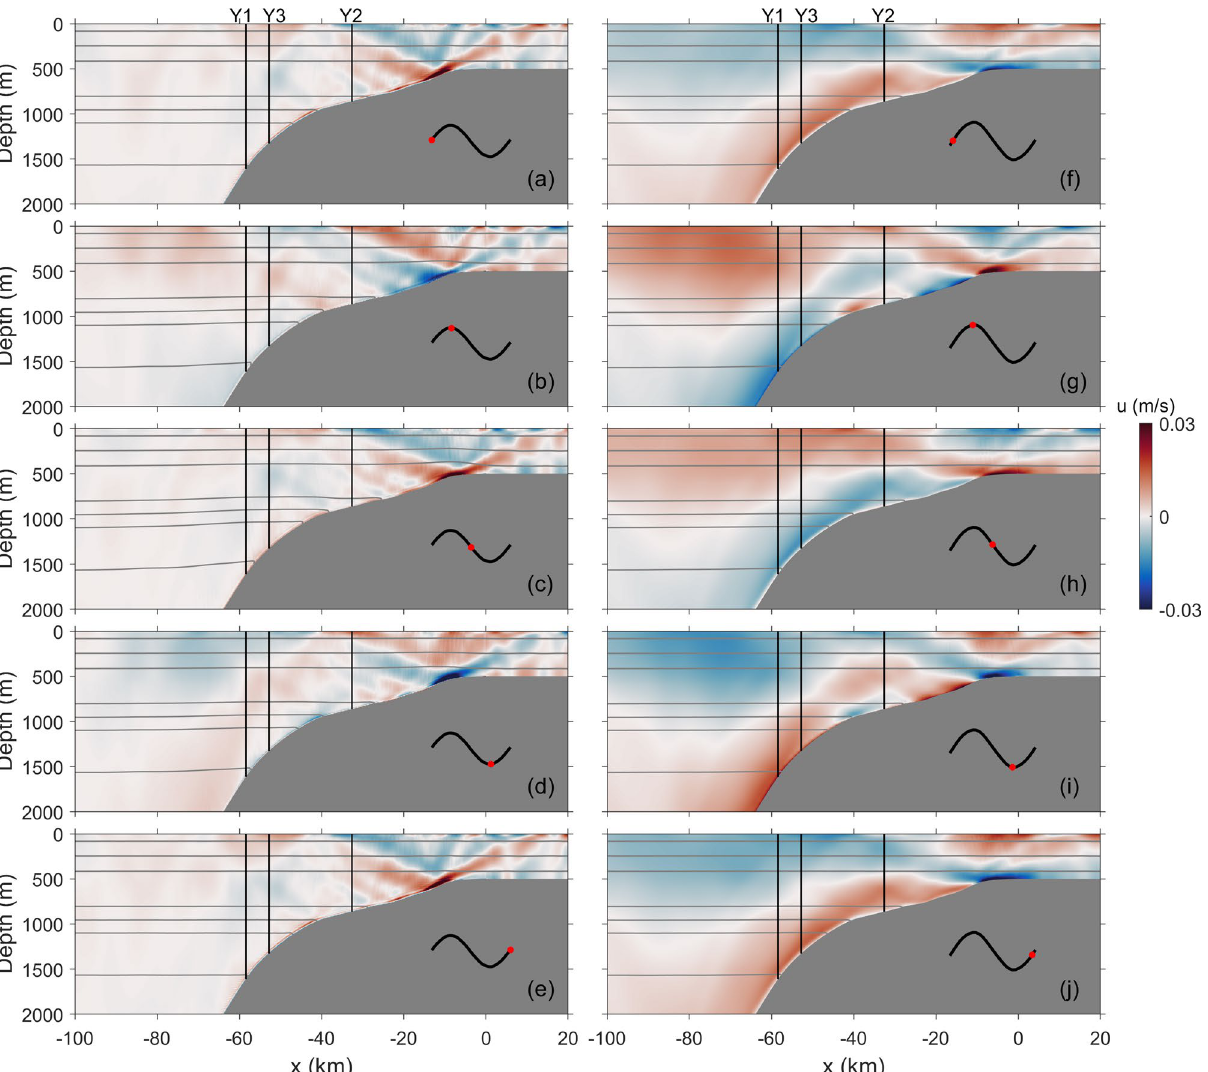
Figure 7. Snapshots for run ( a – e ) K1A and ( f – j ) M2A. Cross-isobath baroclinic currents are indicated by shadings (unit: m/s) and isotherms by gray contours. Phase for each snapshot is marked by red dot. Mooring locations are indicated by vertical black